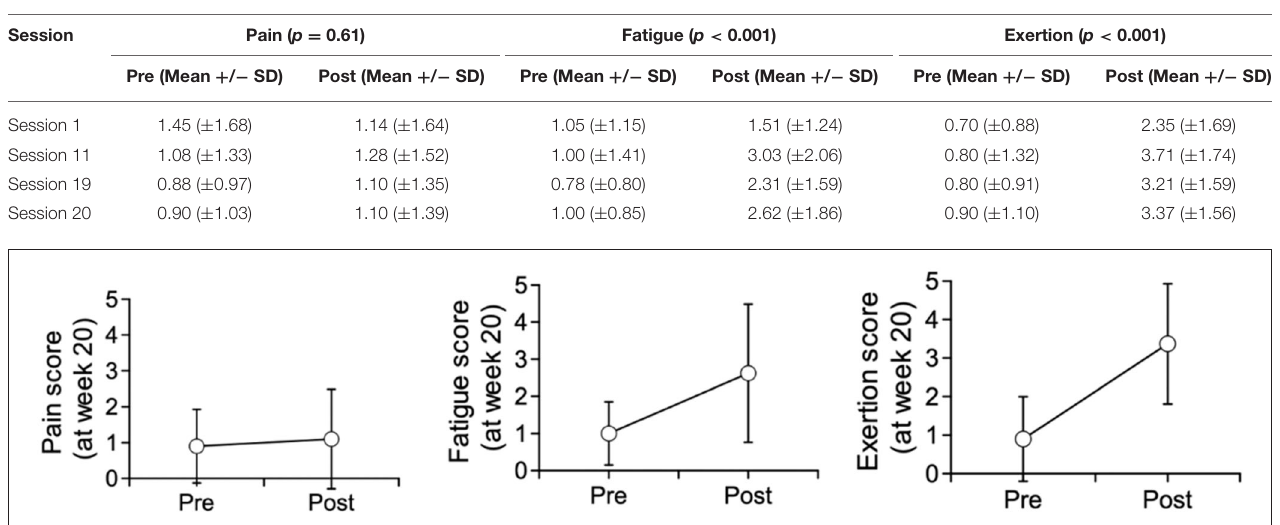
TABLE 9 | Trends in pain, fatigue, and exertion level throughout the entire training protocol by comparing all pre-session scores with all post-session scores ( p -values displayed using student T -test).